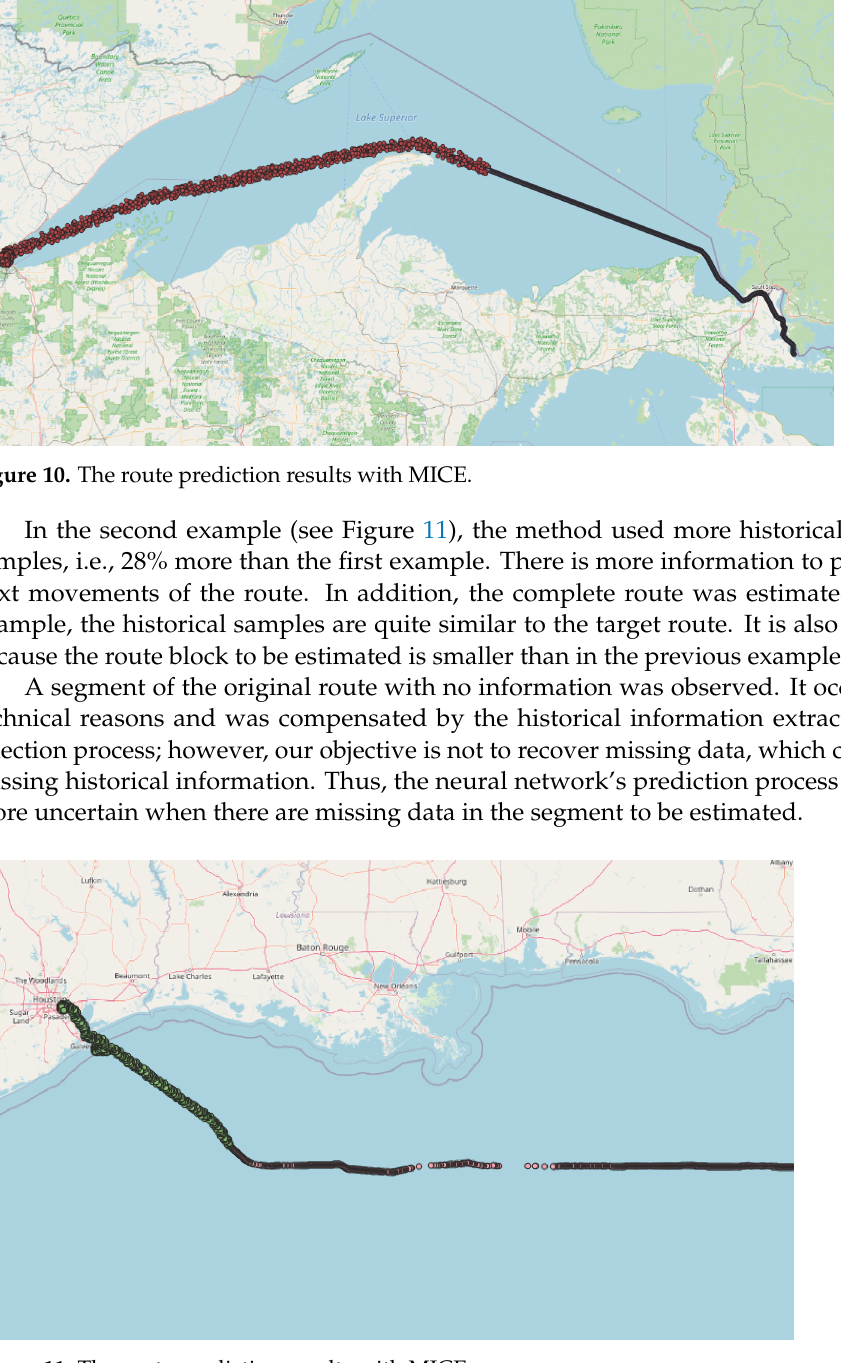
Figure 11. The route prediction results with